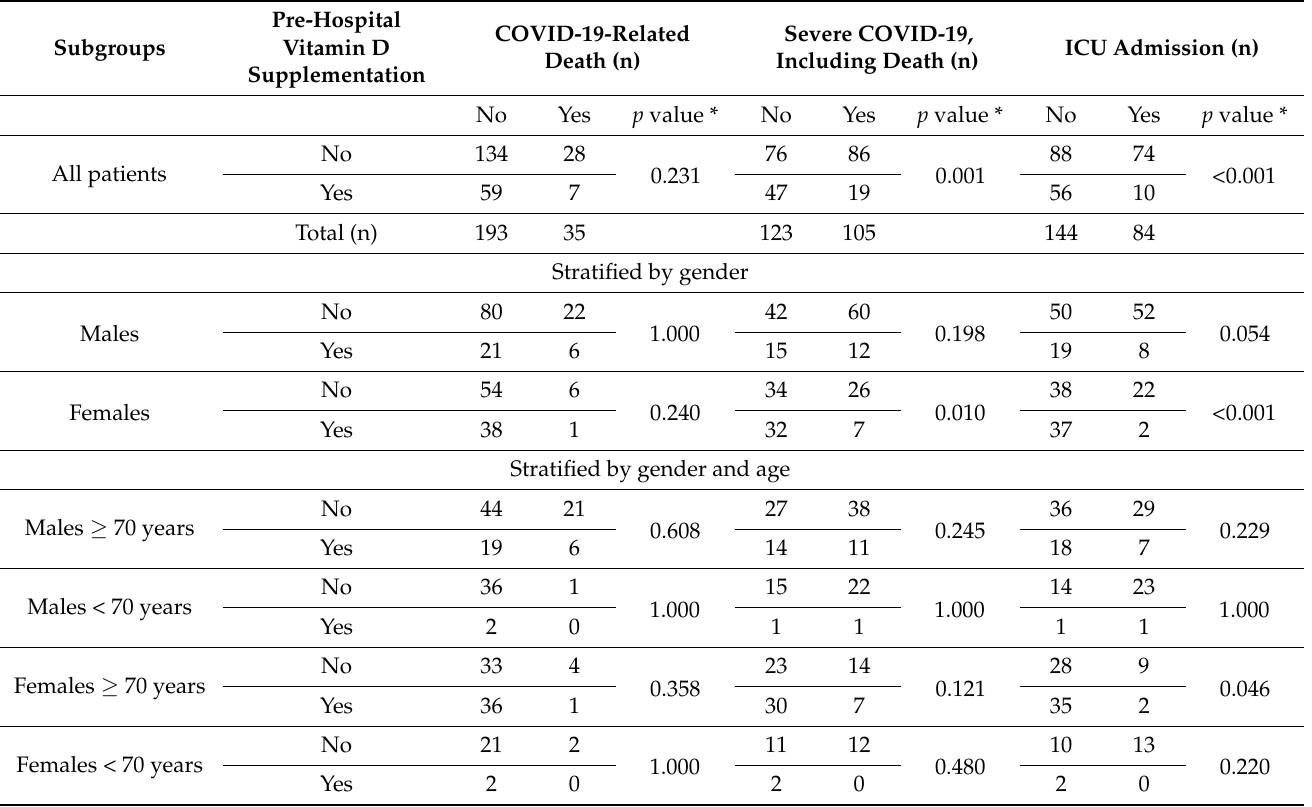
Table 3. Impact of the pre-hospital vitamin D supplementation on COVID-19 severity according to the study